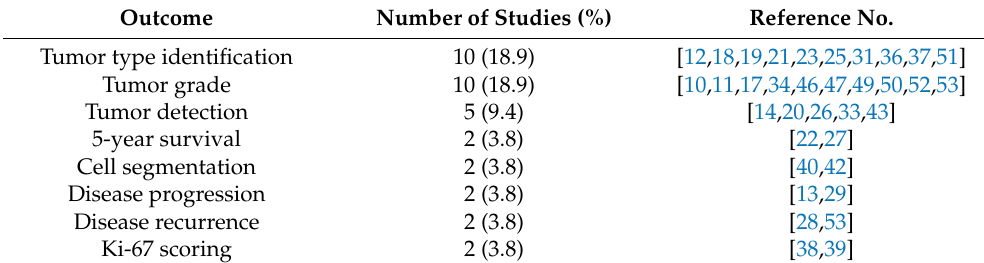
Table 3. Most popular outcome analyses within the included studies.